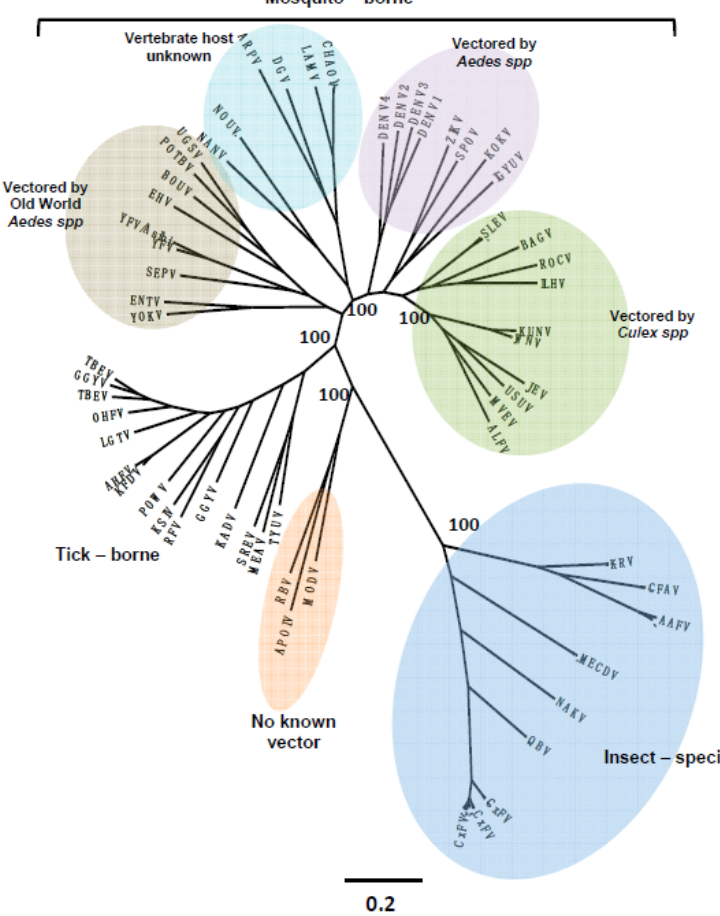
Figure 2. Flaviviruses: Maximum-likelihood analysis of select members of the genus flavivirus . Scale bars indicate amino acid substitutions/site. Branch labels indicate virus abbreviation. Additional virus isolate information is contained in a supplemental file.